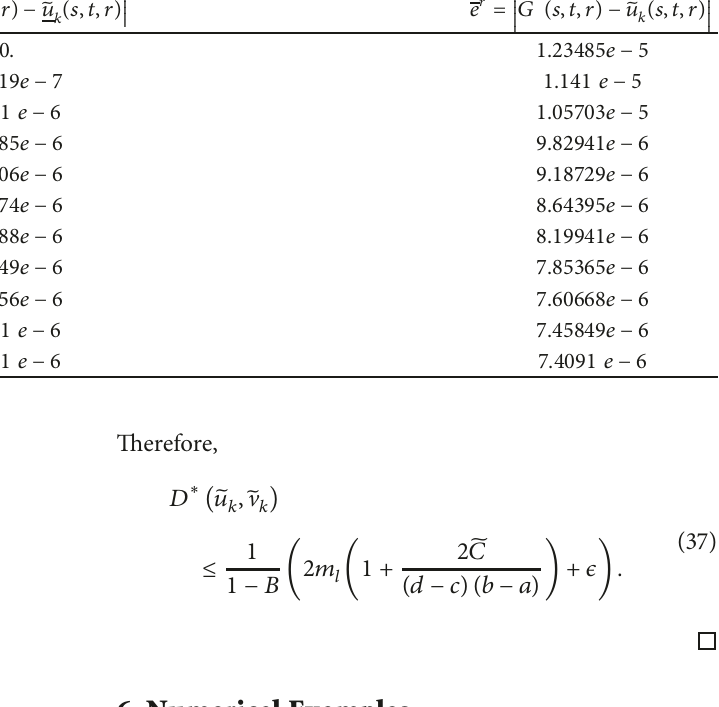
󵄨󵄨󵄨󵄨󵄨̃𝐺 ∗ 𝑟)󵄨󵄨󵄨󵄨󵄨 (𝑠,𝑡, 𝑟) − ̃𝑢 (𝑠, 𝑡, 𝑘